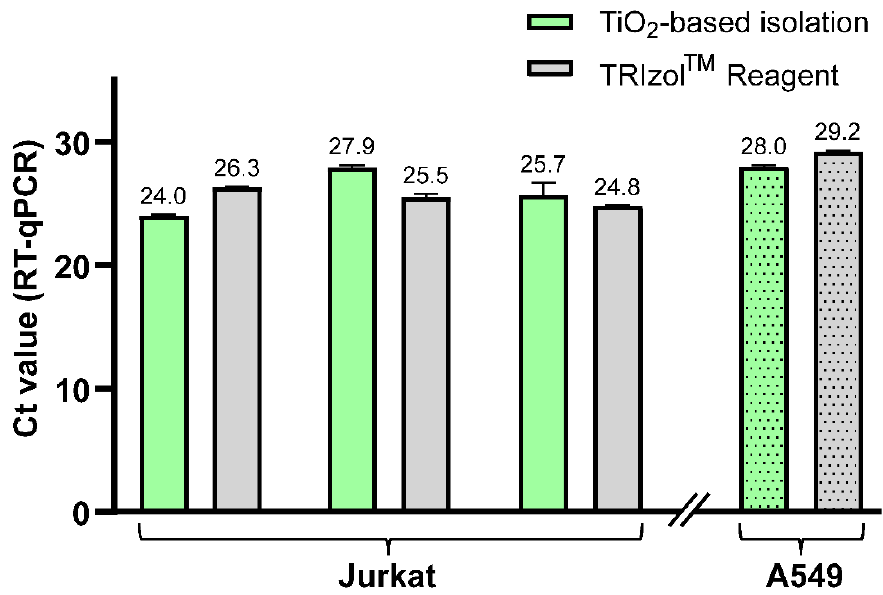
Figure 5. The Ct values of endogenous hsa-miR-18a-3p, obtained from RT-qPCR of elution fractions after miRNA isolation using TiO 2 -based isolation method (green) and TRIzol Reagent isolation (gray) from Jurkat cells and A549 cells (dotted pattern).